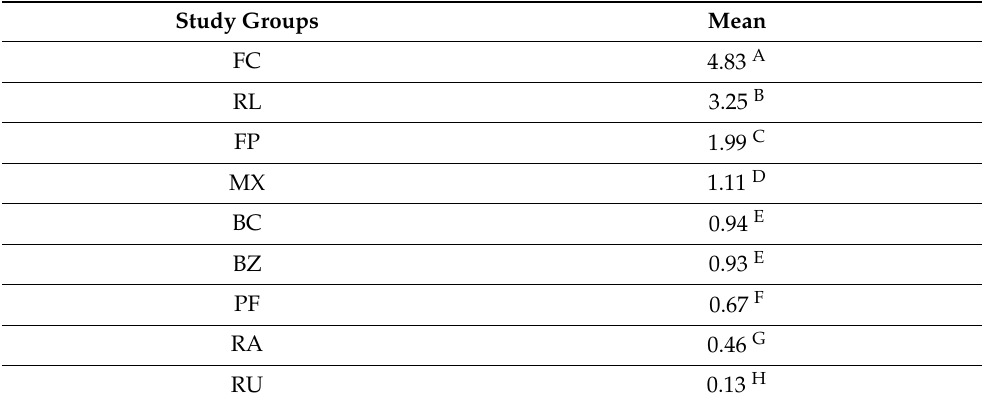
Table 7. Comparison of overall WSL (%) means among cements investigated in the study using Tukey Multiple comparisons test.